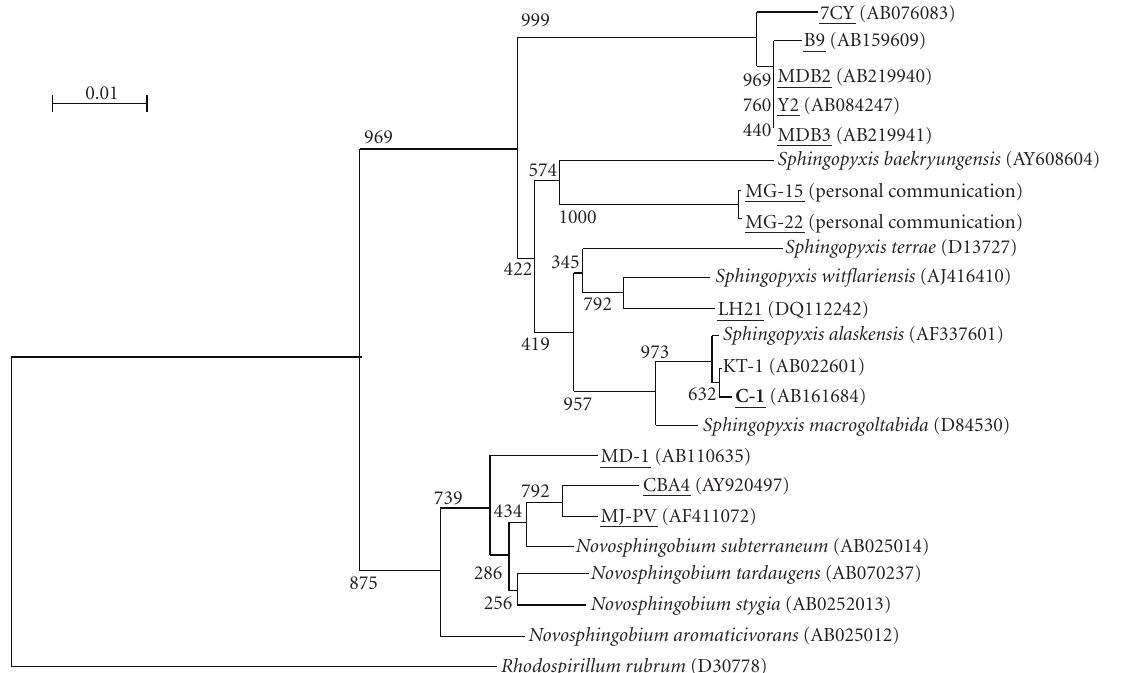
Figure 1: Neighbor-joining phylogenetic tree based on 16S rRNA gene sequences indicating the position of isolate C-1 (in bold type) in relation to other related species, including previously isolated MC-degrading bacteria (underlined). Numerical values represent bootstrap support. Scale bar represents expected changes per site.